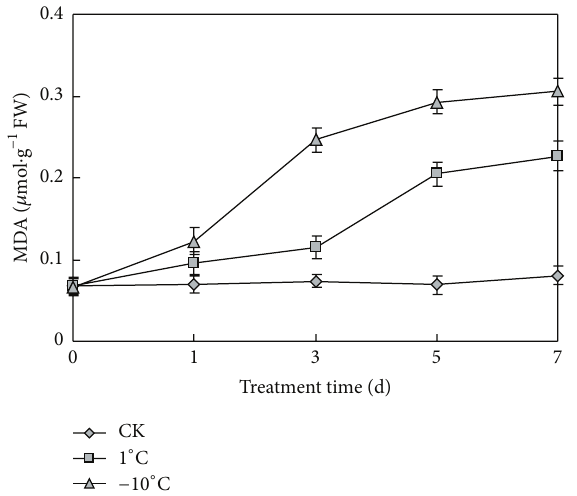
Figure 5: MDA content of seedling leaves under normal and low temperatures. CK represents normal growth condition. Each value is the average ± standard error ( ± SE) result of three independent